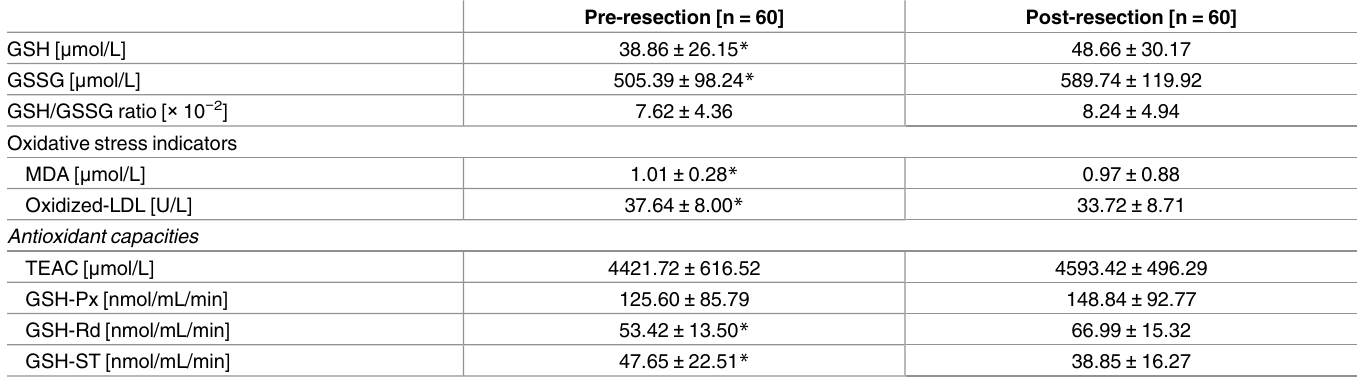
Table 2. Plasma reduced and oxidized, glutathione, indicators of oxidative stress,and antioxidant capacities in patients with hepatocellular carcinoma.